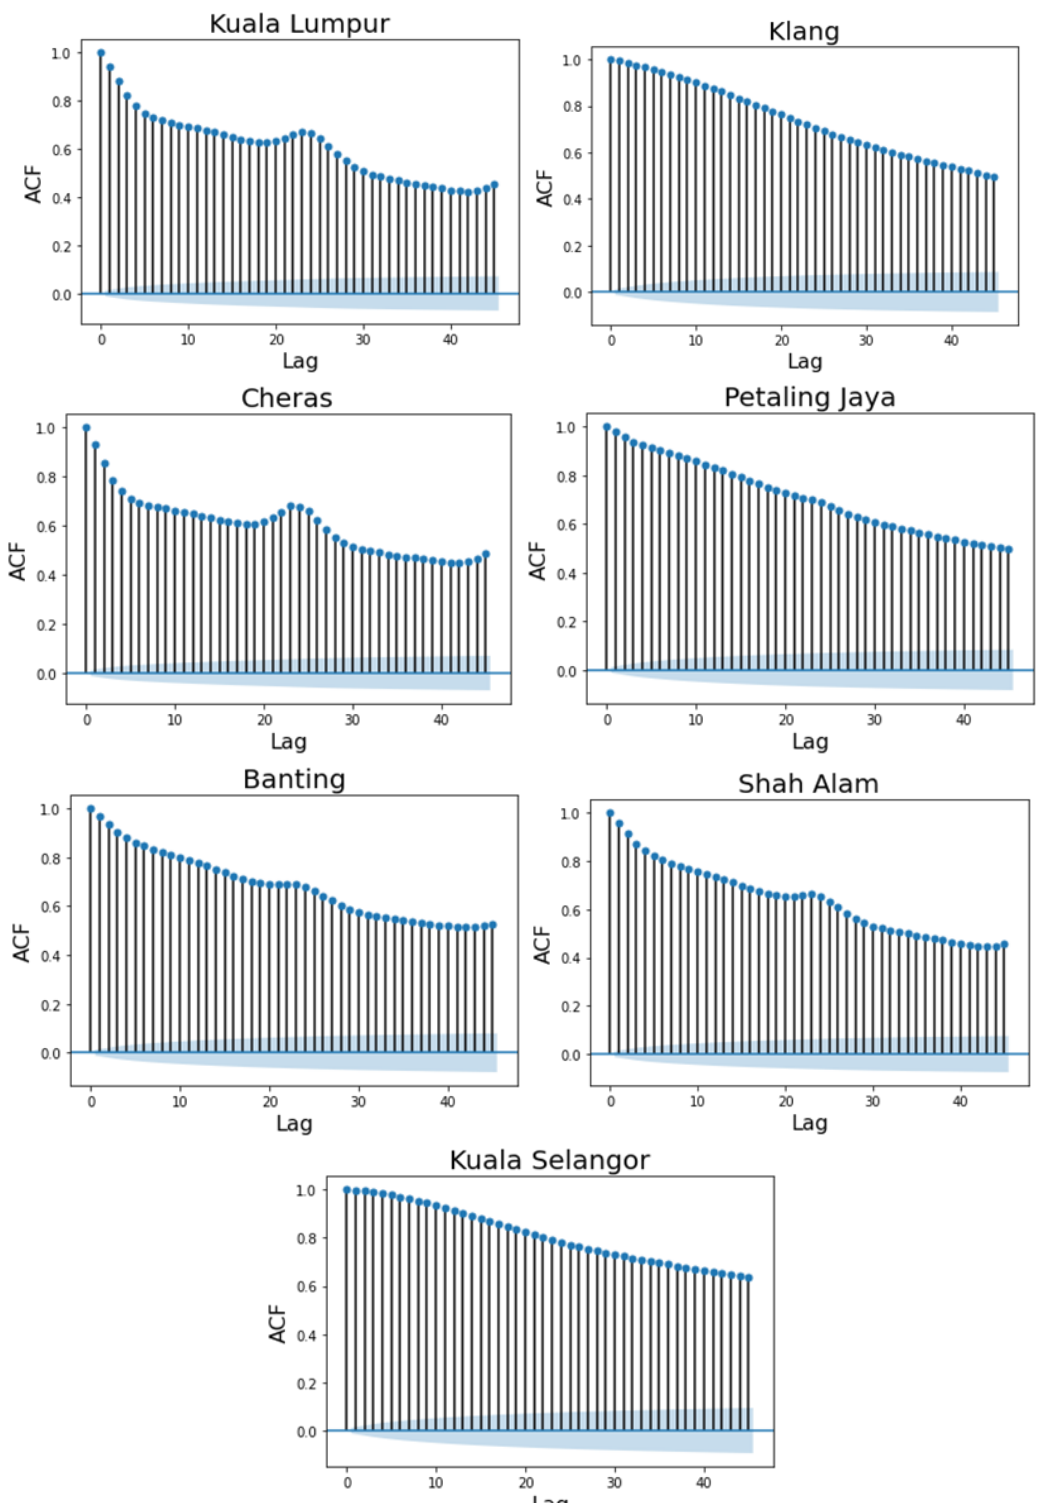
Figure 3. Visualization of the autocorrelation function (ACF) for API data.